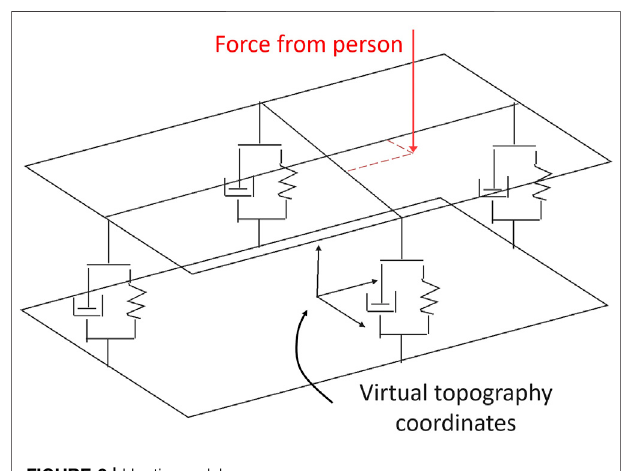
FIGURE 2 | Haptic